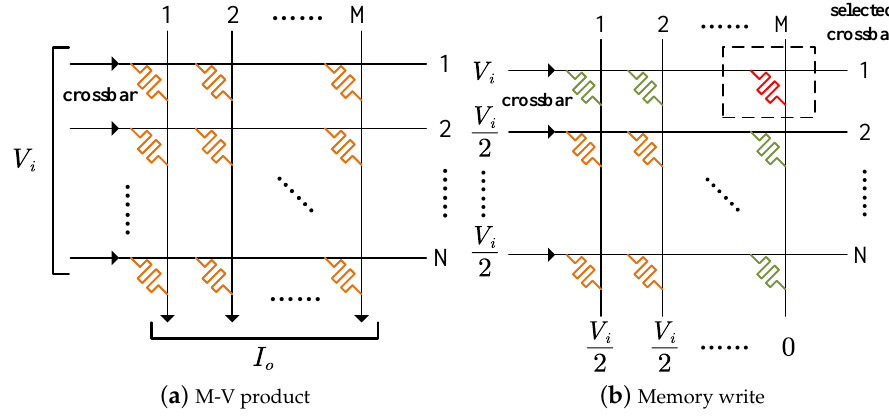
Figure 10. RRAM crossbar and the basic operations on it [64]. All the operations are realized by the changes of voltage